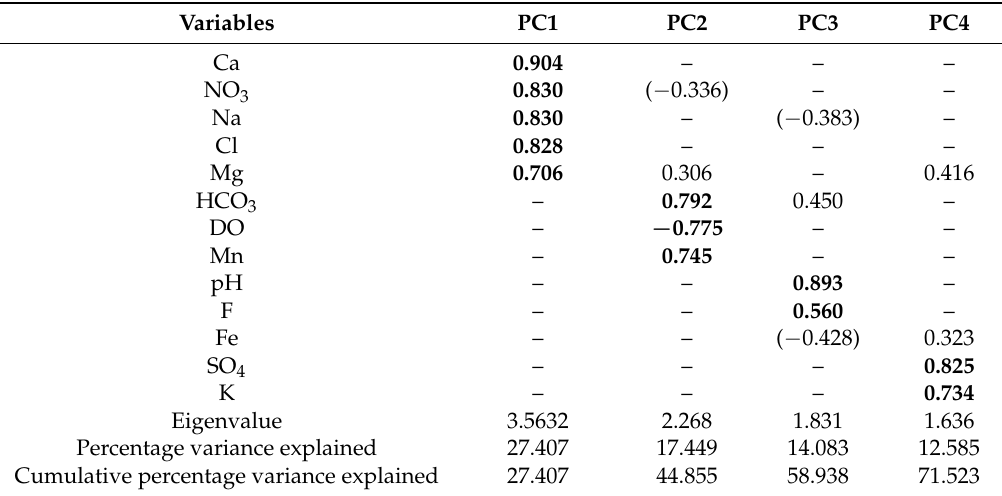
Figure 3. Principal component (PC) loading plots: ( a ) PC1 vs. PC2; ( b ) PC1 vs. PC3. Table 3. Loadings of principal components rotated by varimax